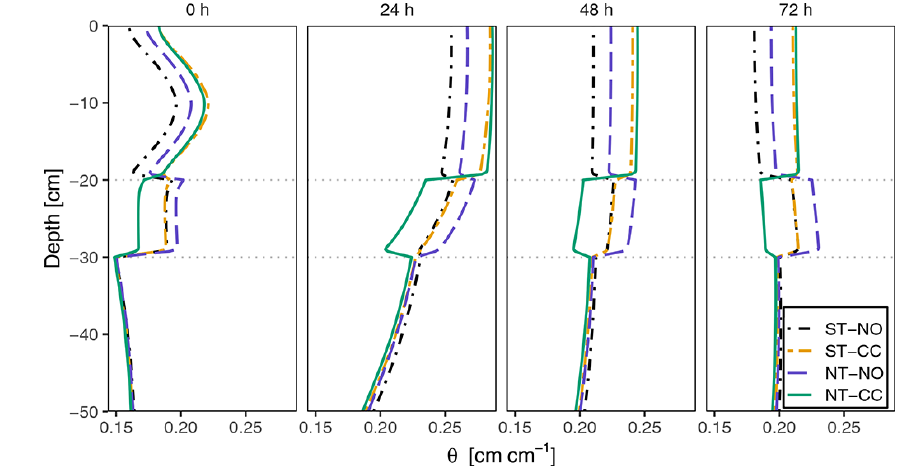
Figure 7. Vertical soil water content distribution 0, 24, 48, and 72h after irrigation (treatment means). The gray, dotted horizontal lines indicate the different soil boundaries.